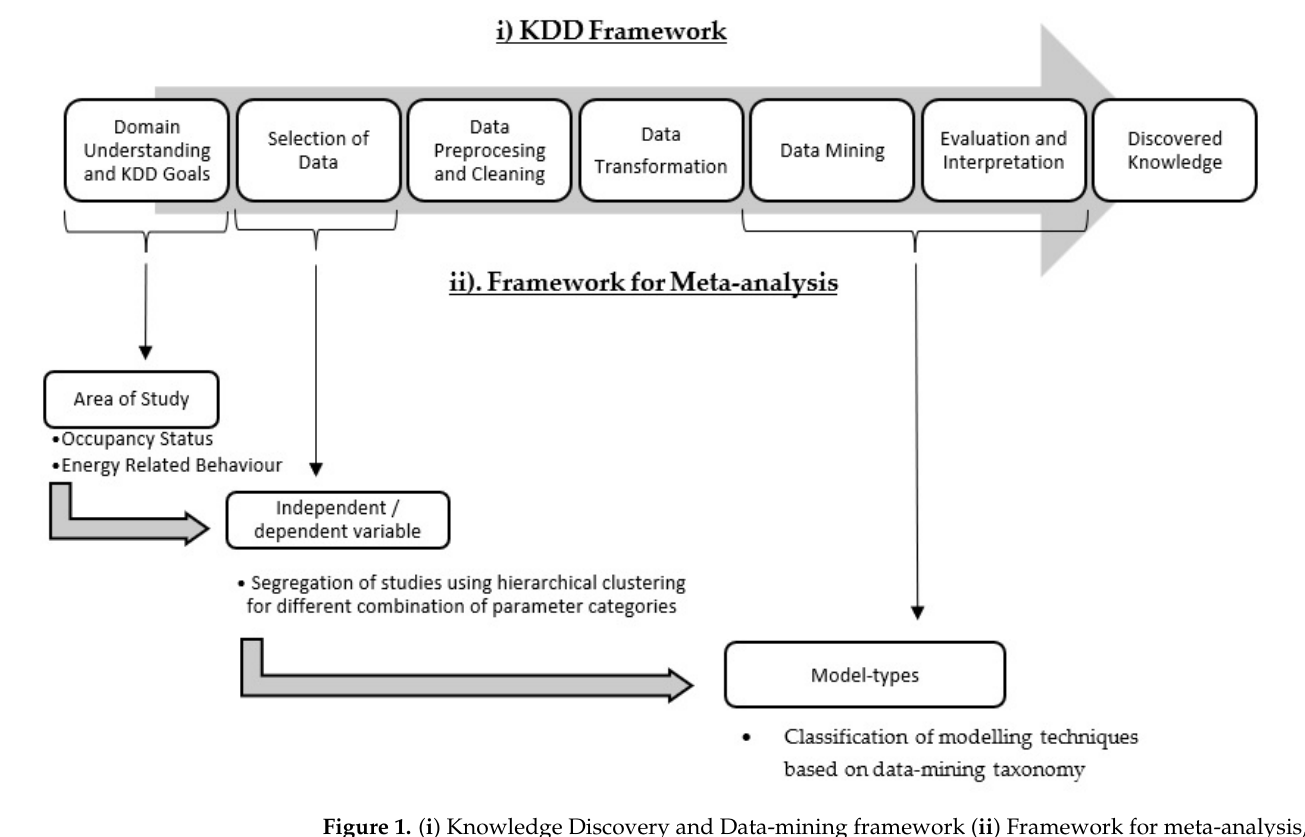
Figure 1. ( i ) Knowledge Discovery and Data-mining framework ( ii ) Framework for meta-analysis, which is derived from the KDD framework.